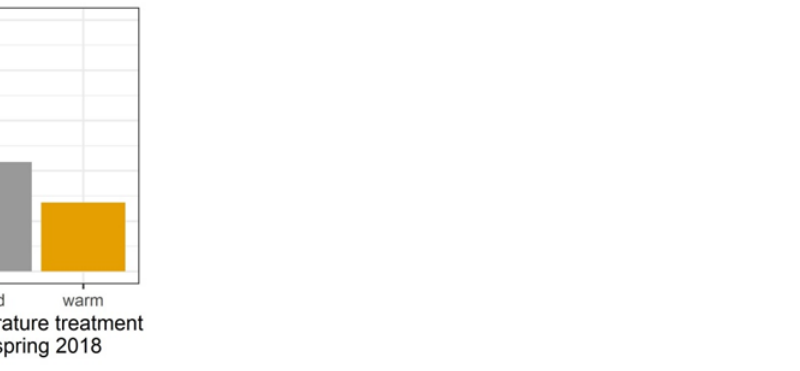
Figure 6. Modeled probability of displaying frost damage in the spring of 2019, depending on the temperature treatment in the spring of 2018.